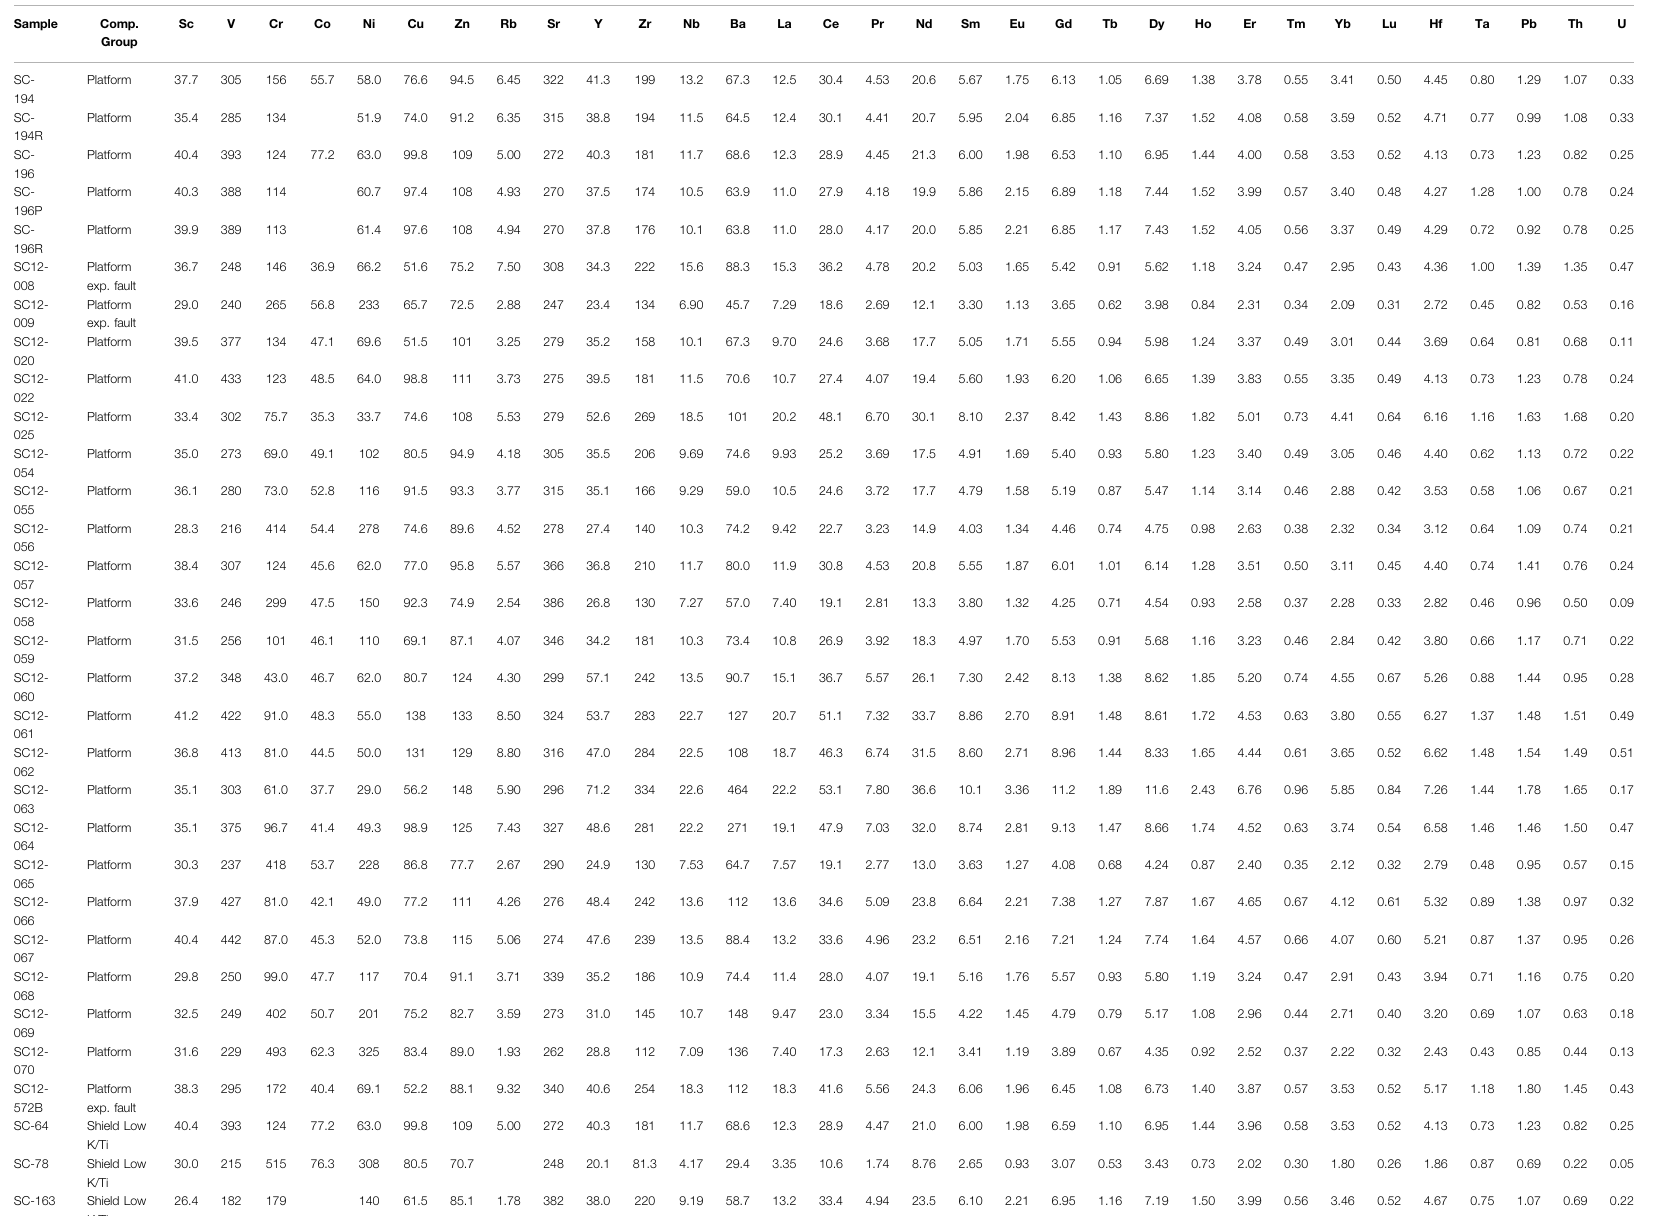
TABLE 2 | Trace element abundances of Santa Cruz lavas, reported in parts per million (ppm). One replicate analysis (indicated by “ re ” ) is included. Sample Comp.